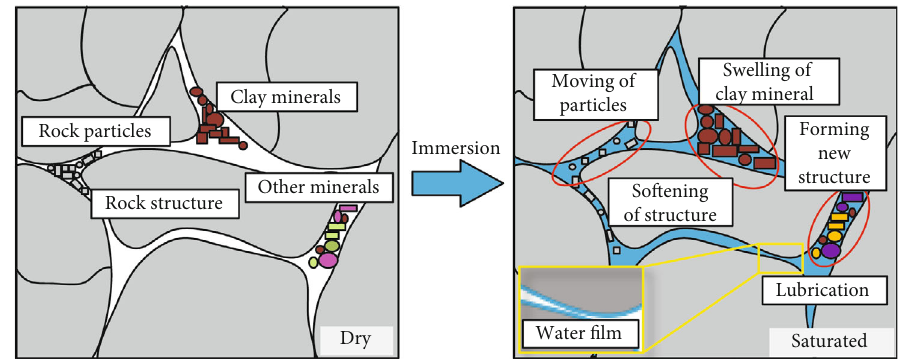
Figure 1: Principle of water-rock interaction after immersion.